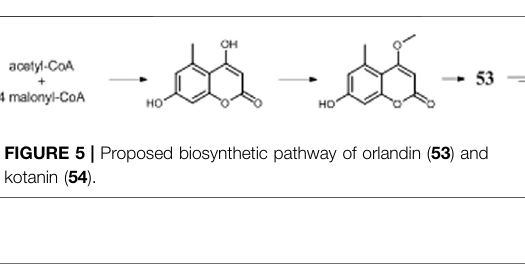
Frontiers in Chemistry |